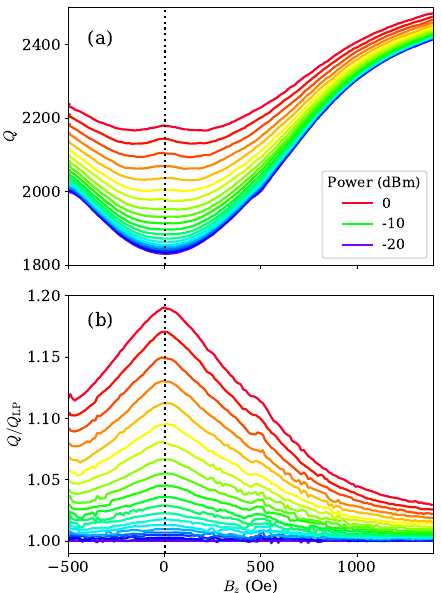
Figure 2. ( a ) resonator Q vs. applied magnetic field at 4.00 GHz and powers from − 20 to 0 dBm; ( b ) resonator Q divided by the Q at –20 dBm to emphasize the decoupling effect. The sharp peak around zero field suggests that this decoupling is associated with the clock